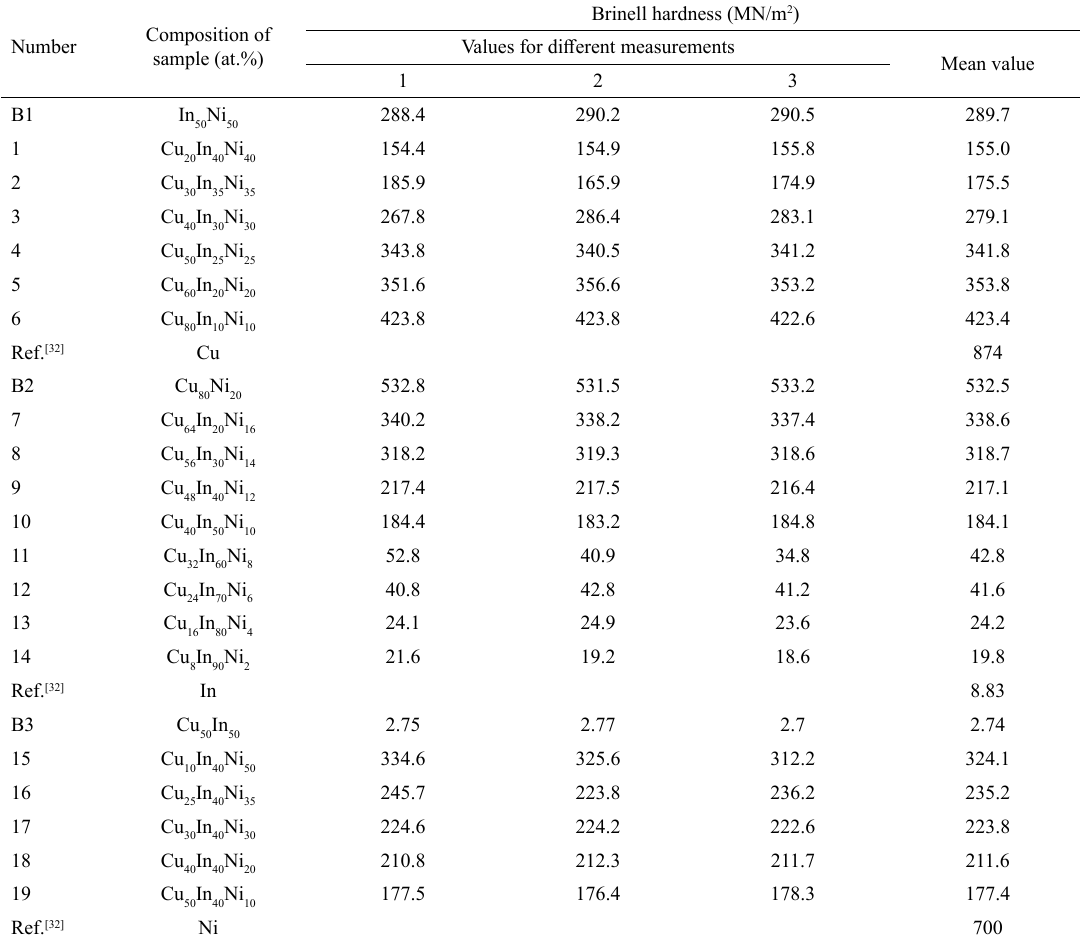
Table 3. Brinell hardness of the investigated alloys from the Cu-In-Ni ternary system Composition of Number sample